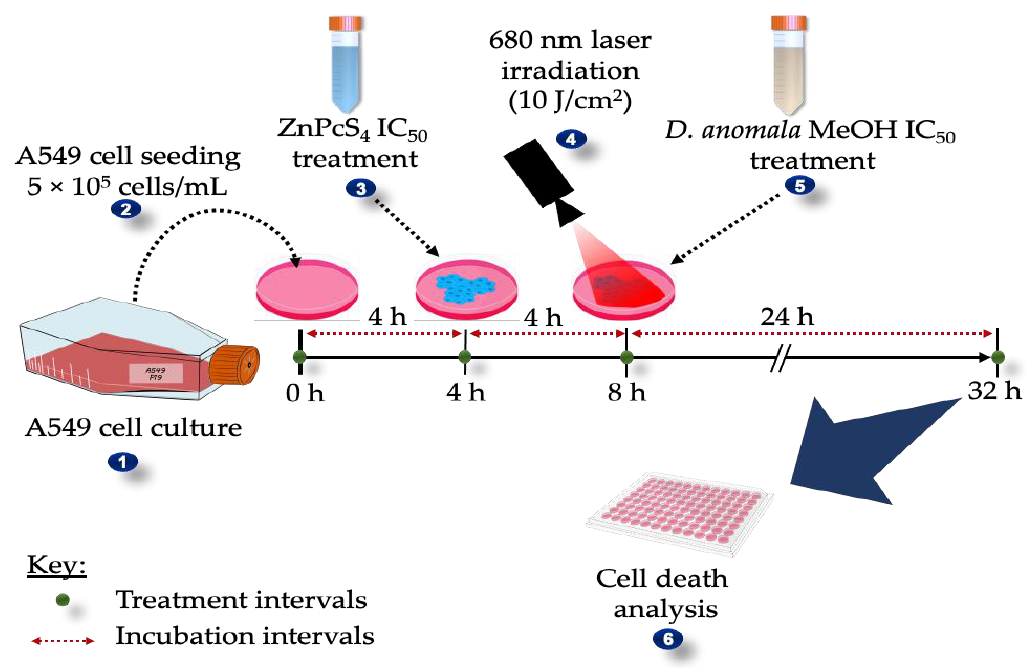
Figure 1. Schematic representation of treatment and incubation time. D.A MeOH IC 50 was added to A549 cells post-treatment with ZnPcS 4 -mediated PDT and incubated for 24 h.